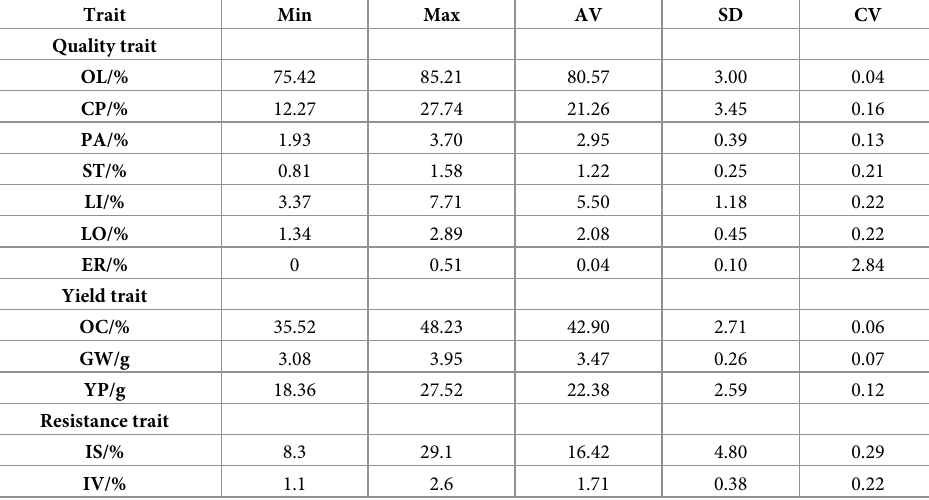
Table 1. Variation coefficients of traits in different high-oleic rapeseed.